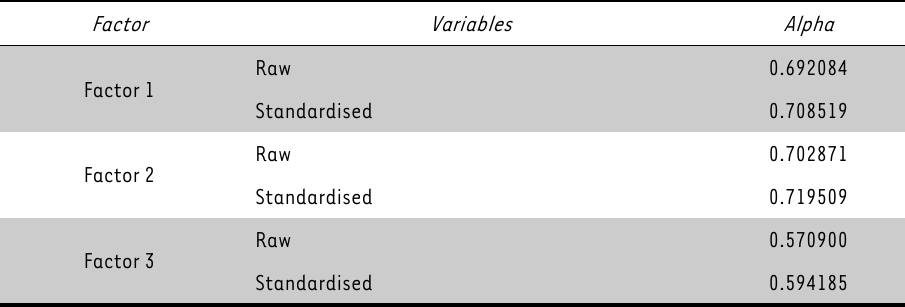
TABLE 3: Cronbach coefficient alpha for the three identified factors